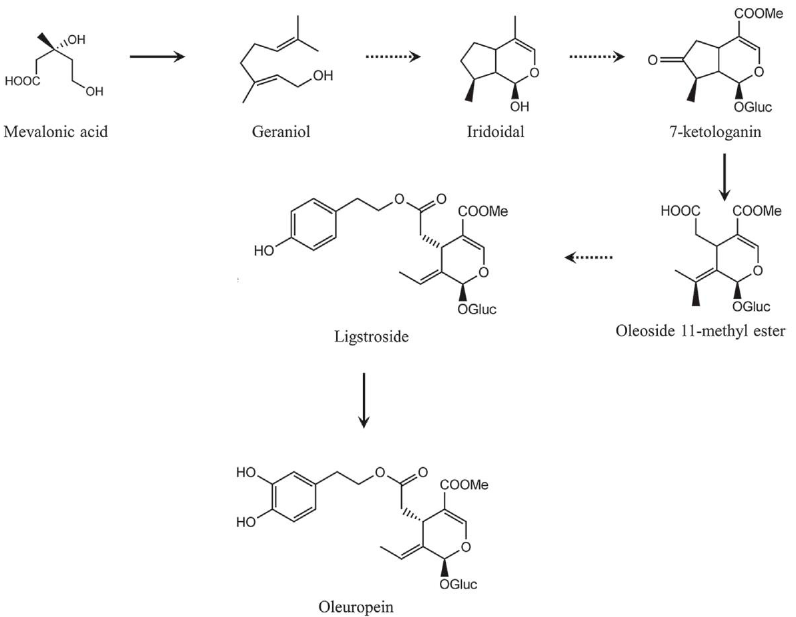
Figure 16. A simplified scheme of the oleuropein biosynthesis .